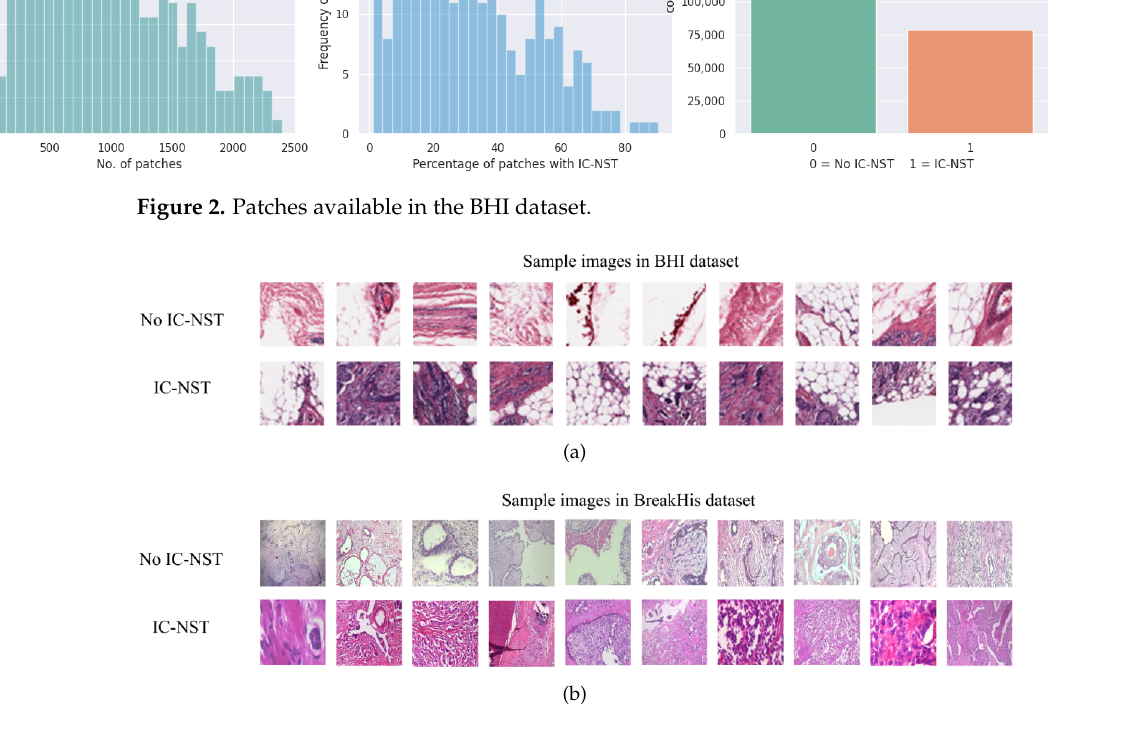
Figure 3. Histopathology image samples in the ( a ) BHI and ( b ) BreakHis